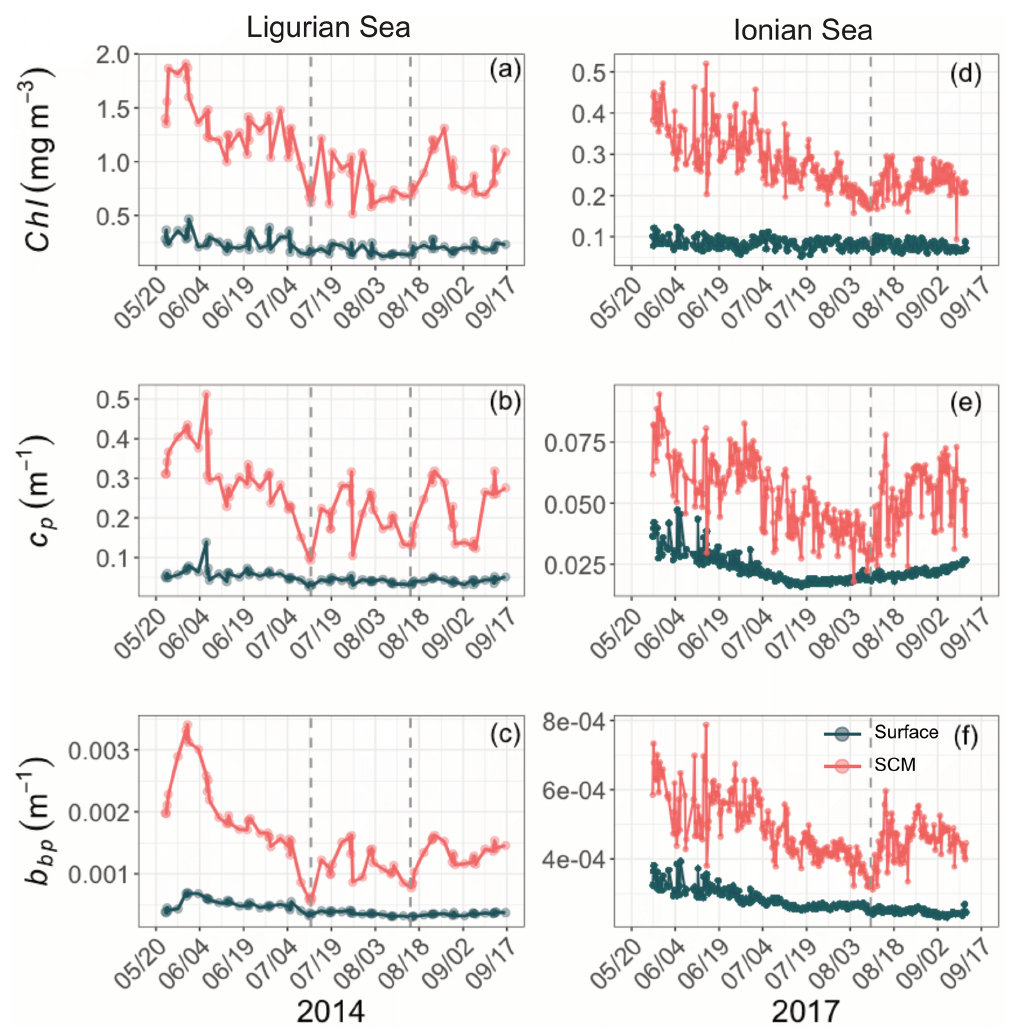
Figure 4. Temporal evolution of Chl (a, d) , c p (b, e) and b bp (c, f) in the surface (dark green) and SCM (red) layers for the Ligurian Sea (a–c) and the Ionian Sea (d–f) . The dashed lines indicate the dates when the values of c p and b bp in the SCM layer reach a minimum. Please note that the date format in this figure is month/day.